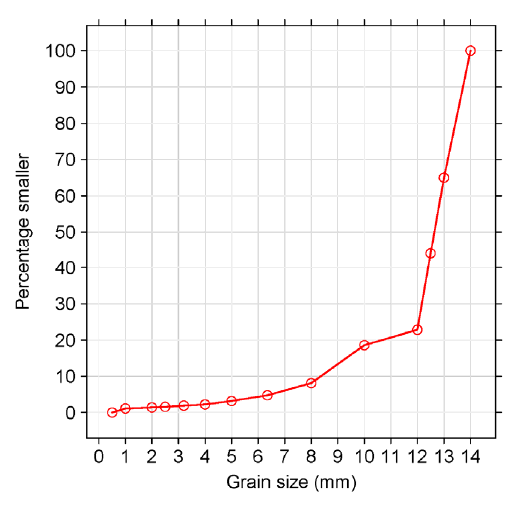
Figure 9. The grain size of the drainage layer.